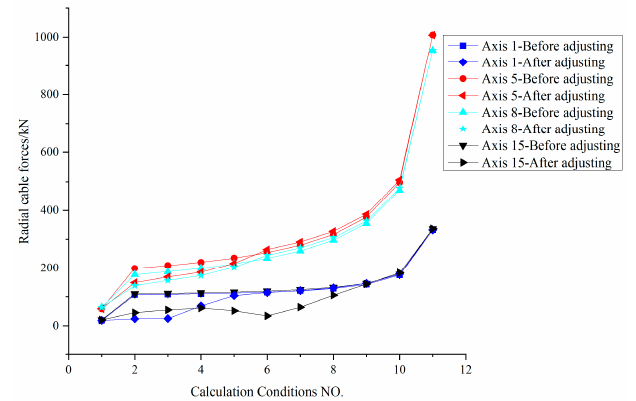
Figure 33. Traction cable forces are almost the same before and after adjusting.